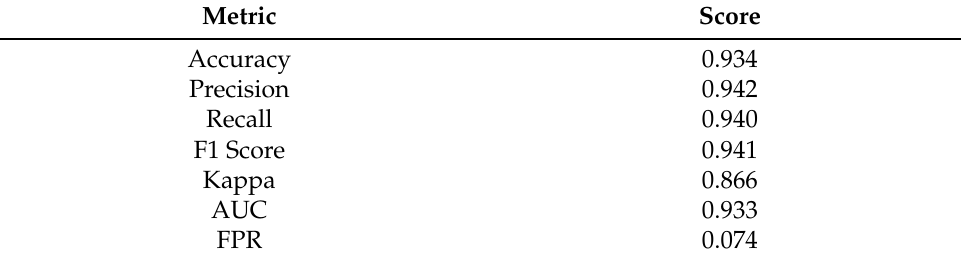
Table 8. Average metric values analyzed for the entire